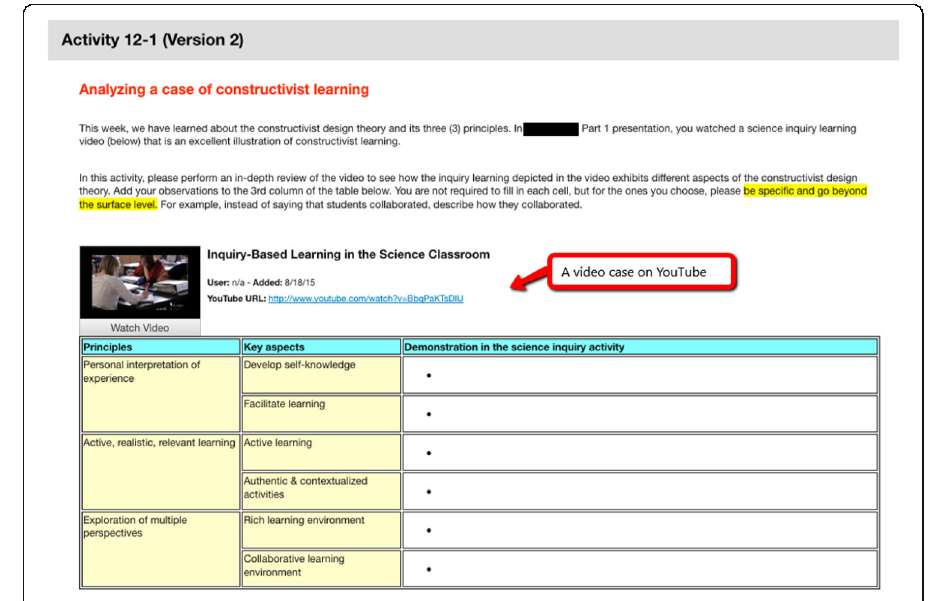
Fig. 1 A template used to scaffold cooperative wiki work in analyzing a video case of inquiry learning in